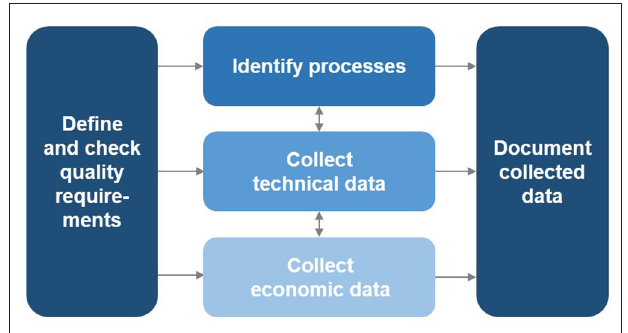
FIGURE 5 | Five phases of TEA inventory